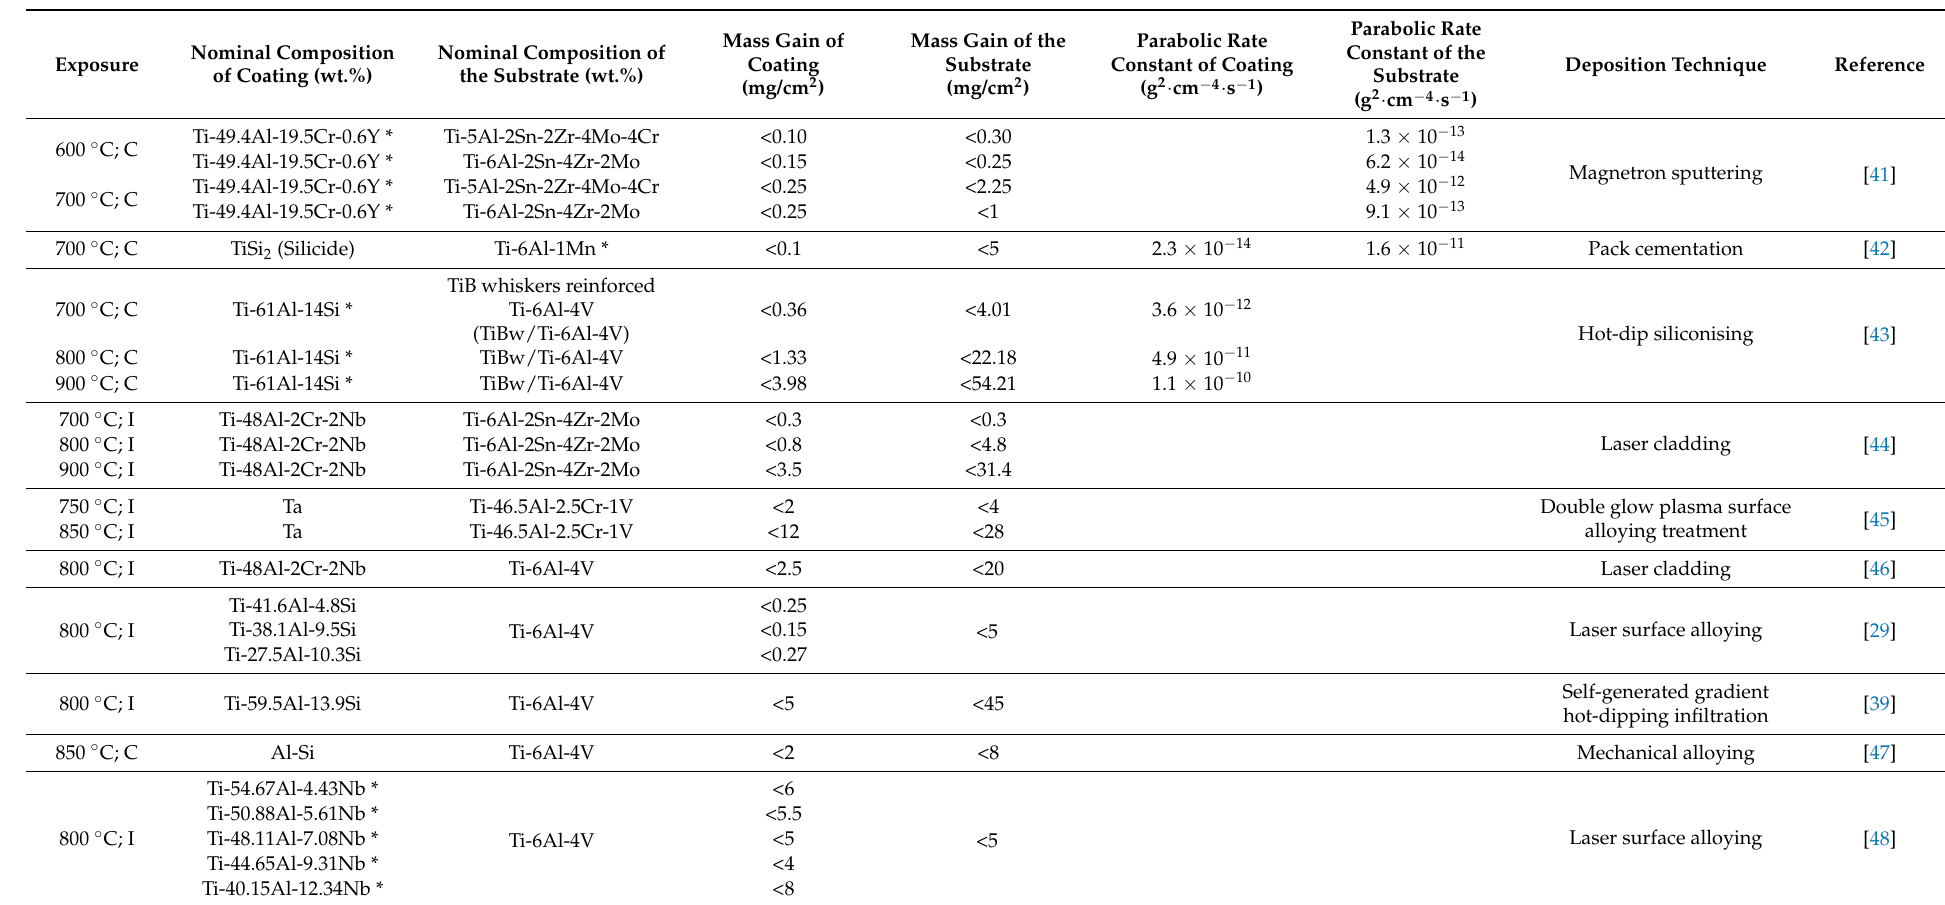
Table 2. Summary of the high-temperature exposure, nominal composition, mass gain, and parabolic rate constant for Ti-Al alloy coatings and their uncoated substrates developed by various deposition